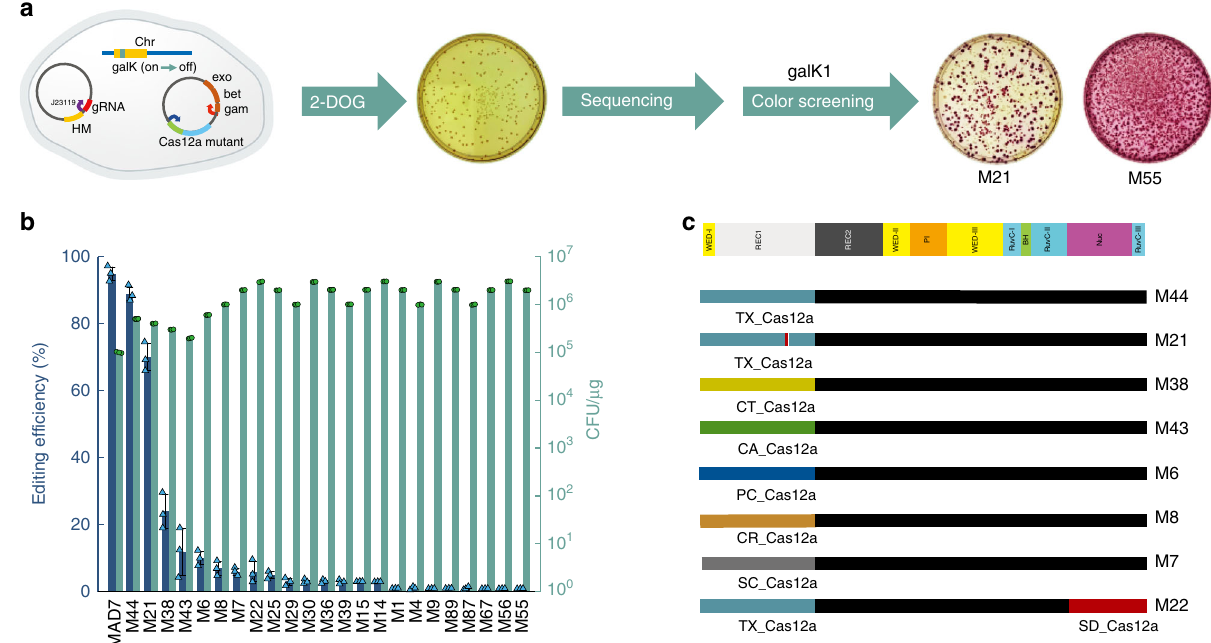
Fig. 2 Veri fi cation of functional chimera library variants. a The work fl ow to verify positive variants. We constructed a two plasmid system for genome editing: one plasmid expresses a Cas protein as well as lambda red proteins (exo, bet, and gam) 67 ; a second plasmid expresses a single crRNA (with J23119 promoter) targeting the galK gene and a homology arm (HM) containing a galK -inactivating mutation as a template for recombineering. Strains with GalK inactivation can grow in media supplemented with 2-DOG, while any unedited strains will not grow, eliminating the need for further screening. In addition, the positive mutants were evaluated for editing ef fi ciency in E. coli using a color screening method based on GalK inactivation. In this assay, colonies with active GalK are red and colonies with inactive (edited) GalK are white. b The editing and transformation ef fi ciency test of library variants. Transformation ef fi ciency is de fi ned as the number of colony forming units (cfu) per µ g of gRNA plasmid. c The diagram of positive chimera variants based on the Cas12a structure. (The structure of AsCas12a used as the template.) Source Data are available in the Source Data